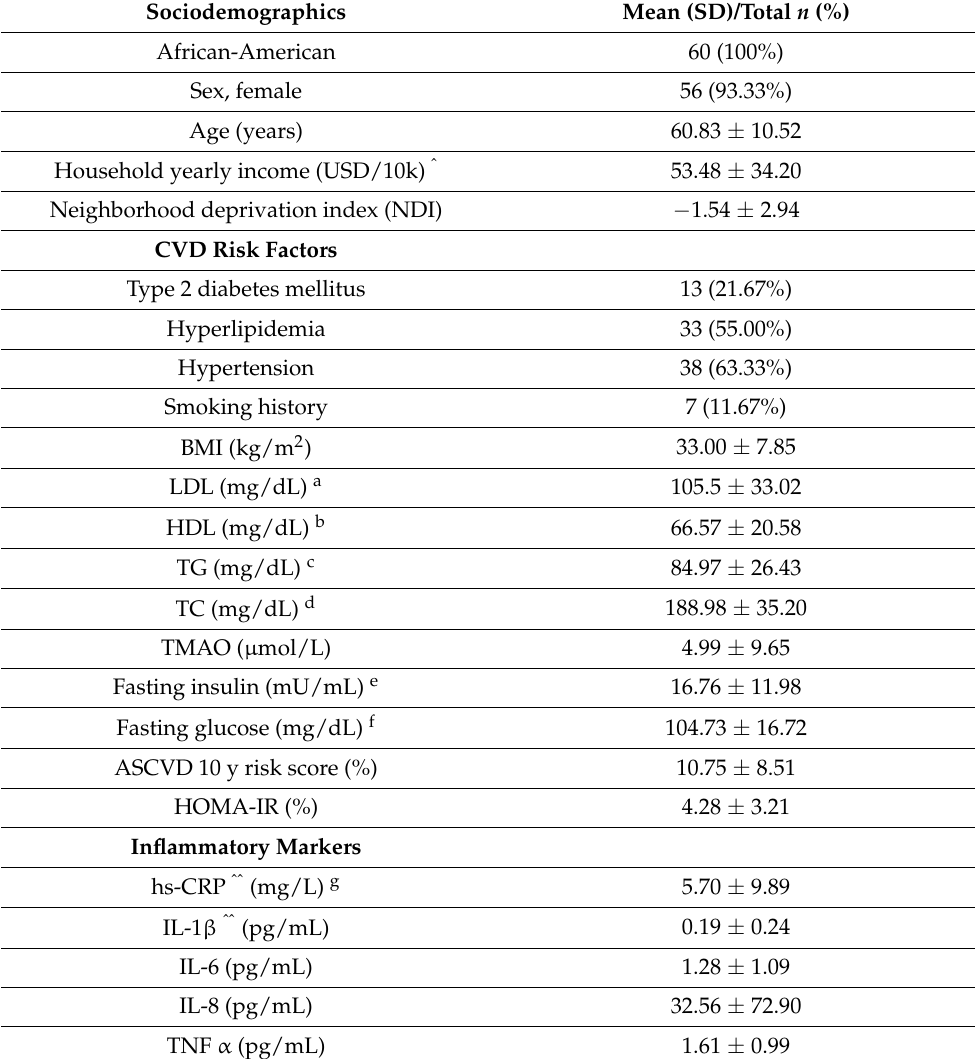
Table 1. Characteristics of participants from Washington, DC Cardiovascular Health and Needs Assessment ( n = 60), who provided survey data and blood